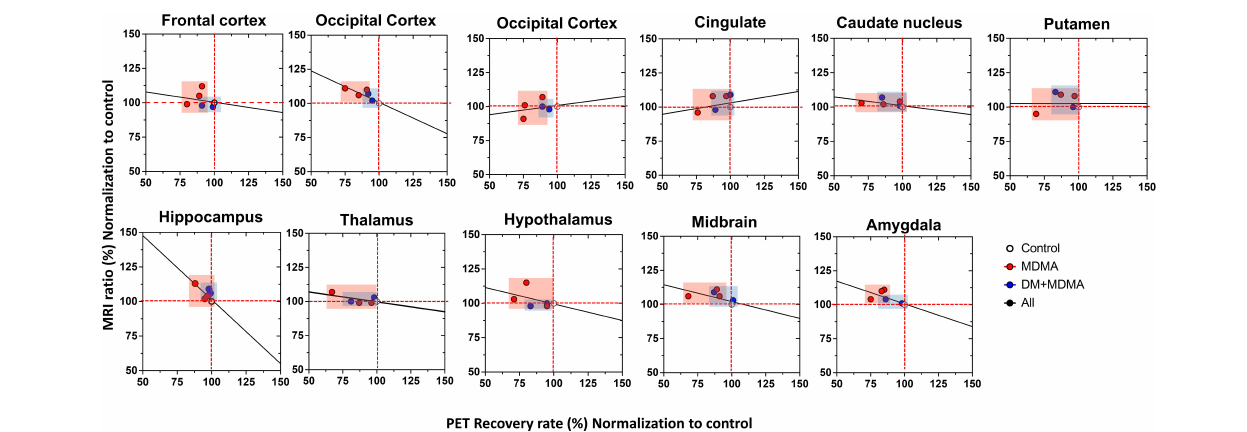
FIGURE 8 | Relationship between the volumetric ratio determined by MRI ( y -axis) and SERT recovery rate determined by [ 18 F]-4-ADAM PET ( x -axis). Increased brain volume negatively correlated with reduced uptake of [ 18 F]-4-ADAM after MDMA administration. Linear correlation coefficients between X and Y are shown when the two variables ranges; MDMA group-pink block, DM-MDMA-blue block, black line-all grange/group (R 2 -values for each region are shown in Table 4 ).